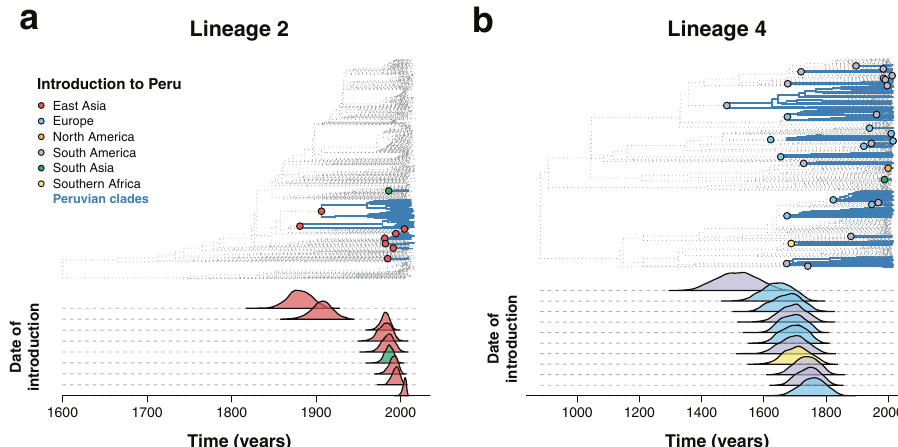
Fig. 4 Phylogeographic analysis of Mycobacterium tuberculosis introductions to Peru. a , b Inferred introductions of Mycobacterium tuberculosis in Peru. The top part shows a time-calibrated phylogeny, with inferred introductions to Peru highlighted in the nodes with colors representing the country from which the clade was introduced. Peruvian clades are shown in blue. The bottom part shows the estimated year of introduction. The analysis was done separately for a lineage 2 and b lineage 4. For visual representation purposes, only the year of introduction of clades with more than 10 tips are shown for lineage